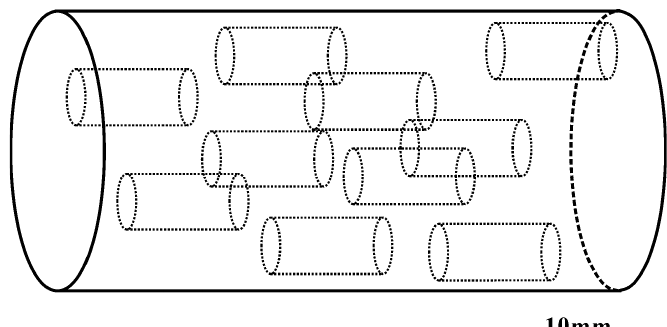
Figure 6. Schematic of subsamples selection.